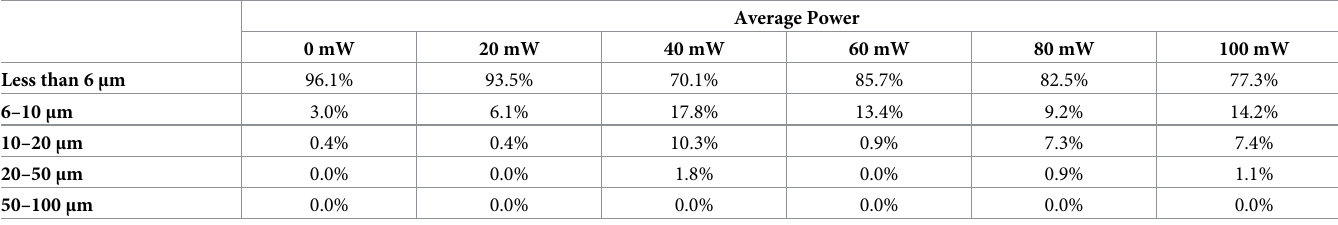
Table 2. Ratio of aggregated pieces generated under each irradiation